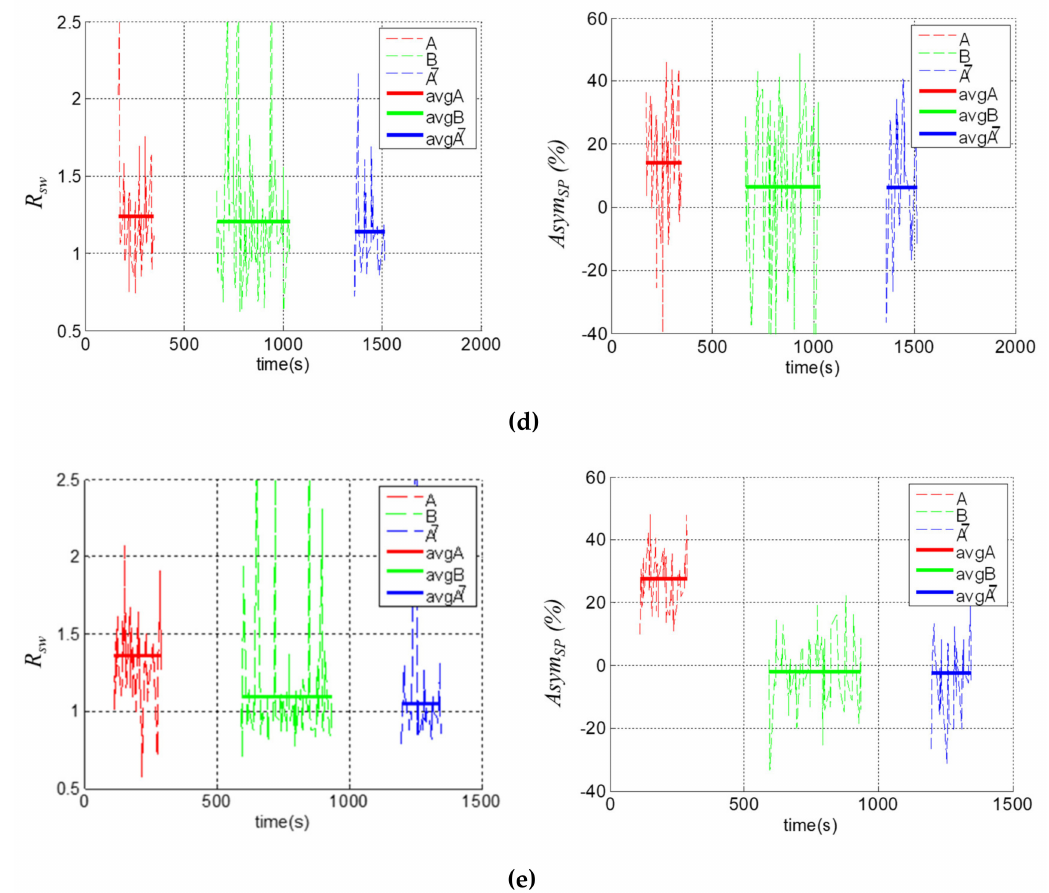
Figure 12. The ratio of the swing time R SW and the asymmetry of the swing phase Asym SP . ( a ) For